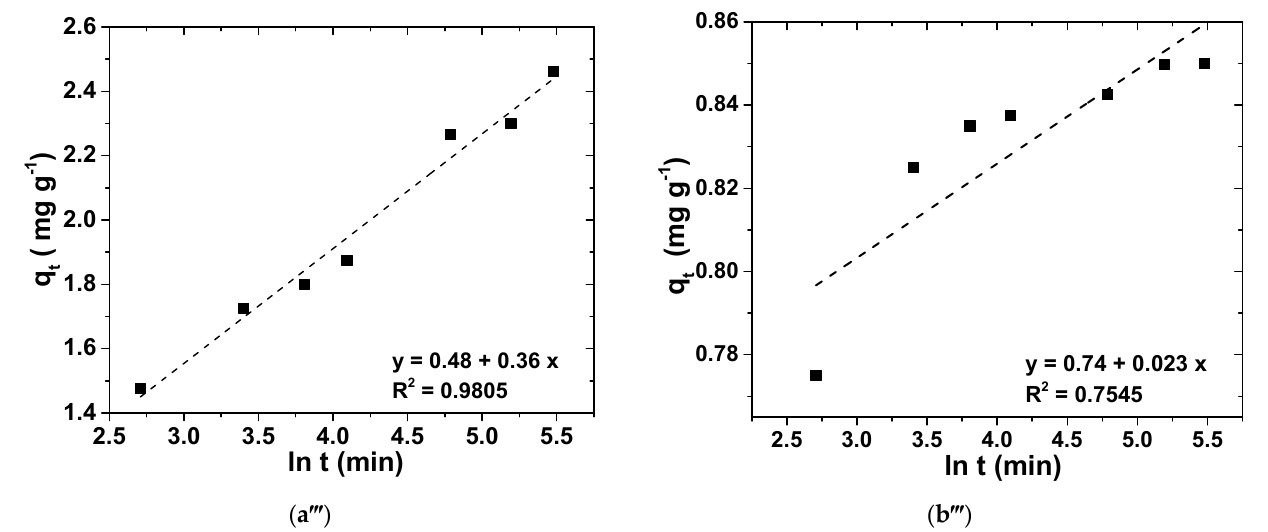
Figure 9. Linear regression analysis of the kinetic models for the adsorption of Mn ( a – a ‴ ) and Zn ( b – b ‴ ) ions on powder Cyprinus carpio scales : ( a , b ) pseudo-first order, ( a′ , b′ ) pseudo-second order, ( a″ , b″ ) intraparticle diffusion, and ( a ‴ , b ‴ ) Elovich model. Fish scale dosage = 2 g/100 mL AMD, 25 °C, 500 rpm.